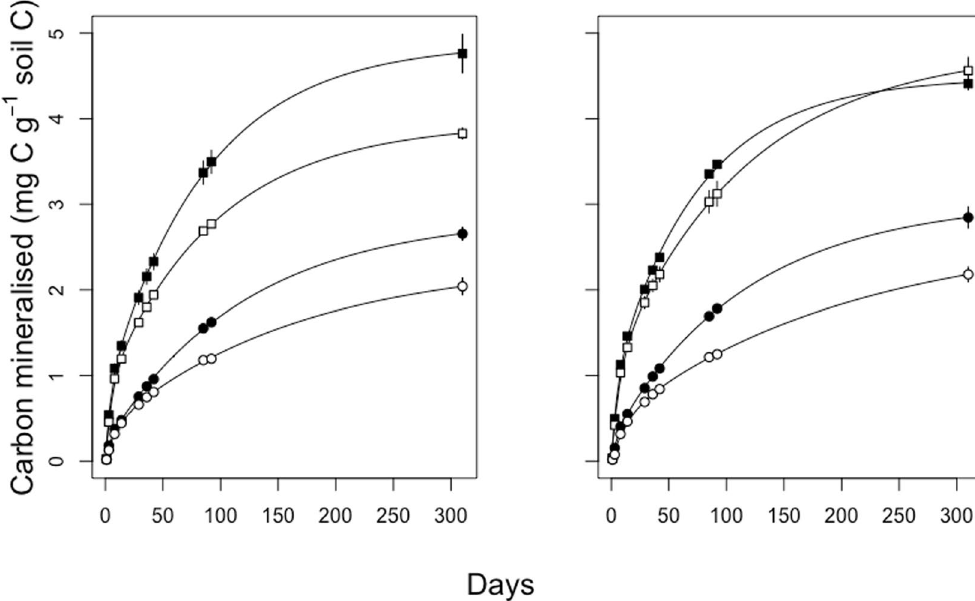
Figure 2. Mean carbon mineralisation curves of the microbial communities from the sandy soil (left panel) and from the silty soil (right panel) when inoculated into the silty soil (square symbols) and into the sandy soil (round symbols). Solid symbols are soils that received the microbial inoculum in the more-connected micro-environments and open symbols are soils that received the inoculum in the less-connected micro- environments. Lines represent model fit. Bars represent standard-error of the mean, where the SEM is greater than the size of the